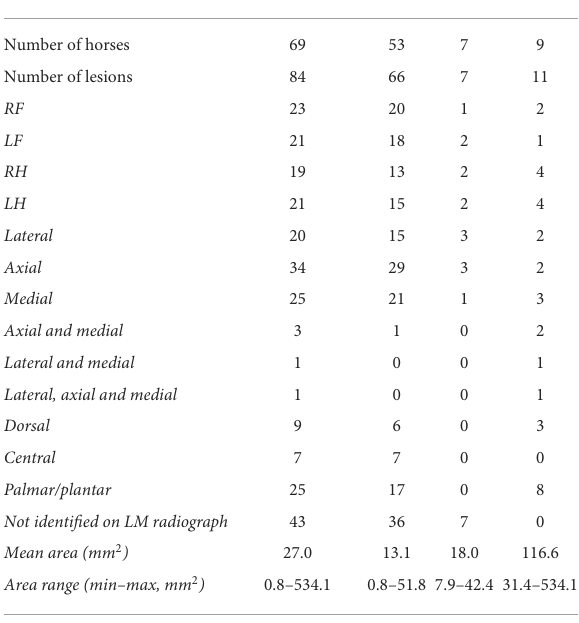
TABLE 3 PIPJ JOC lesion type by degree of joint